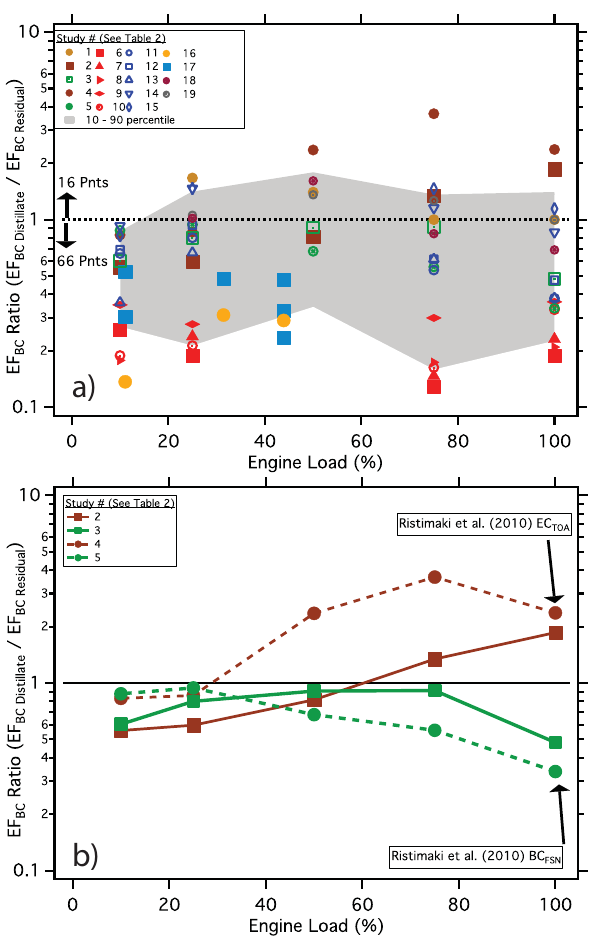
Fig. 6. (a) The change in EF BC as fuel quality improves (as a ra- tio between EF BC-Distillate and EF BC-Residual ). 10th–90th percentile range of data shown as shaded region, (b) Illustration of measure- ment inconsistency.